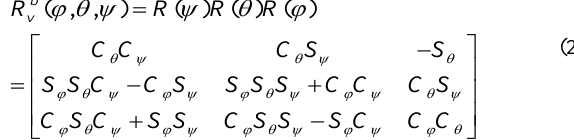
To estimate the 3D coordinates of ground target, target position is computed by intersecting the ray starting from the camera centre and passing through the target pixel location in the image plane with the ground.